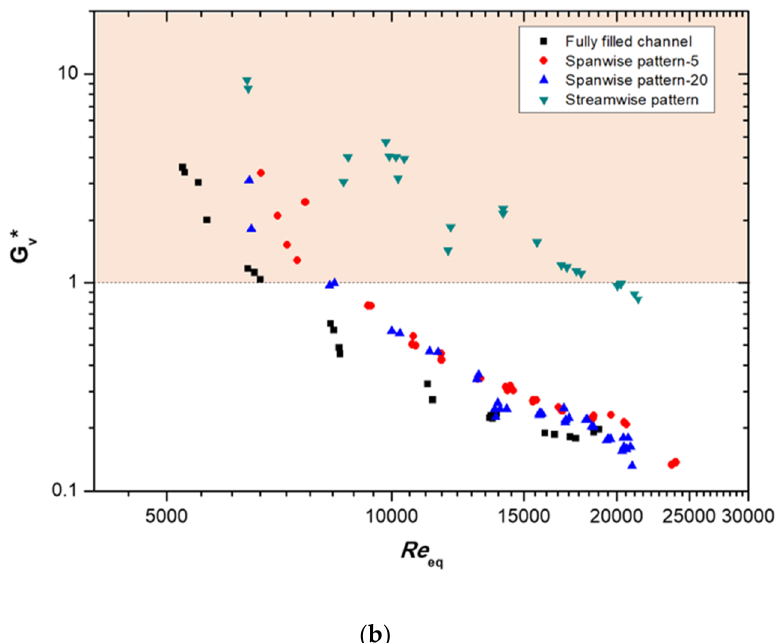
Figure 11. Comparison of ( a ) the ratio of the flow area’s goodness factor and ( b ) the ratio of the volume’s goodness factor between the porous patterned models and the plain channel at G = 133 kg/m 2 s.